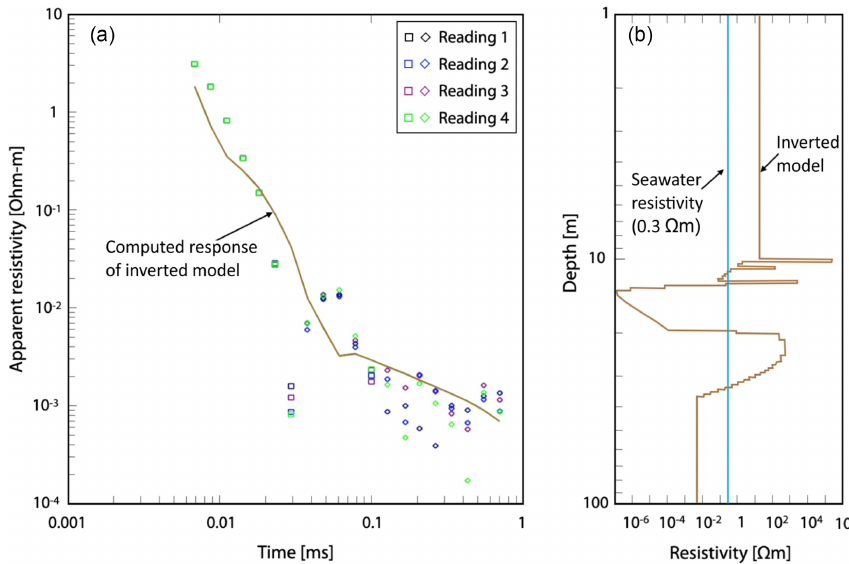
Figure 7. A 1D inversion result for G-TEM data, shown as squares and diamonds (representing positive and negative responses, respectively), at a station located 6m from start of profile May15-1. (a) The computed resistivity depth profile displayed as a curve passing through data points. (b) The best-fit model is marked as the brown line, while the light blue line is the inferred seawater